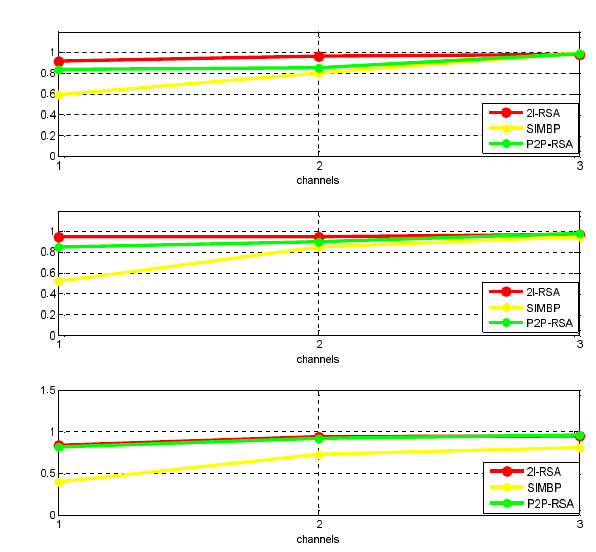
Figure 3. FI evaluated with different algorithms